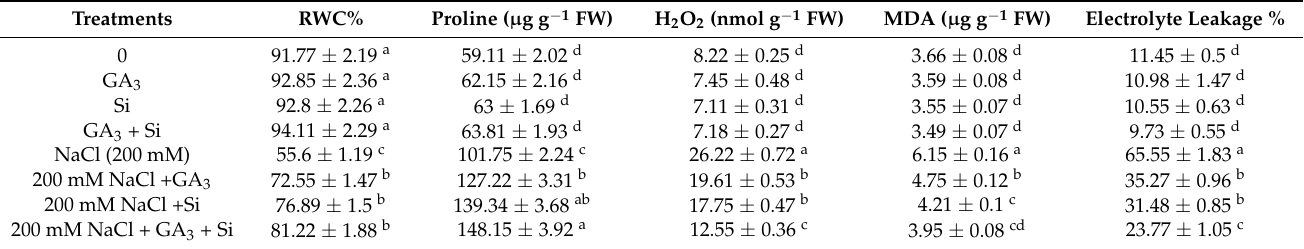
Table 3. Outcome of gibberellic acid (GA 3 ) and silicon (Si) application on RWC, proline, H 2 O 2 , MDA and electrolyte leakage of B. juncea cultivated under NaCl